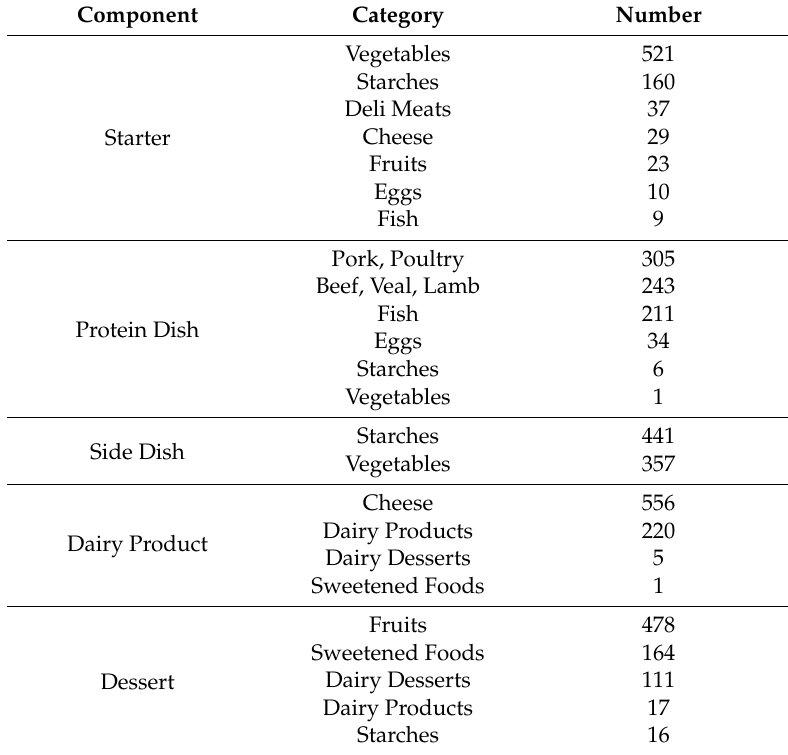
Table A1. Categorization and distribution of dishes per meal component in the 40 observed